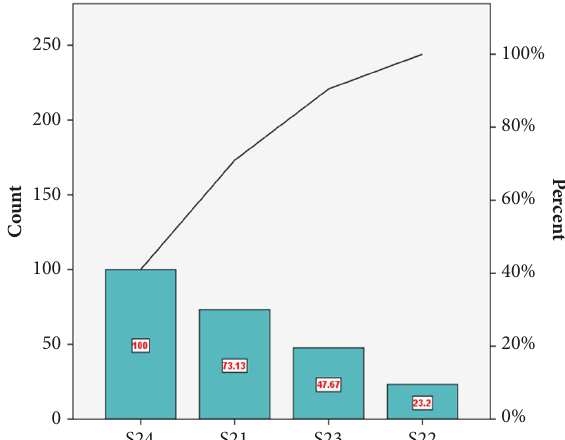
Figure 6: Pareto chart for project planning management process